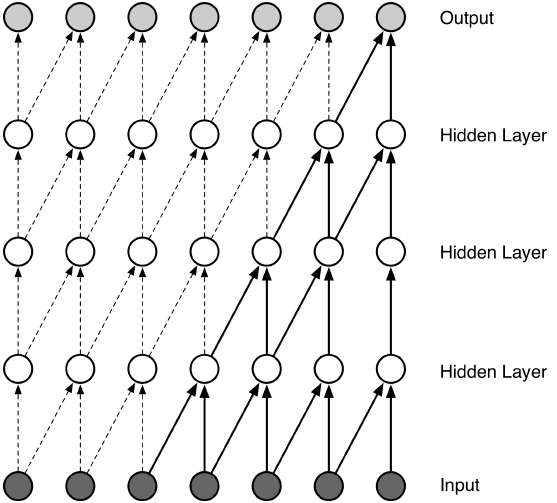
Figure 3. The structure of causal convolution, where each circle is a neuron. Solid arrows are used to depict the data flow of the right-most output neuron, and dashed arrows represent other data